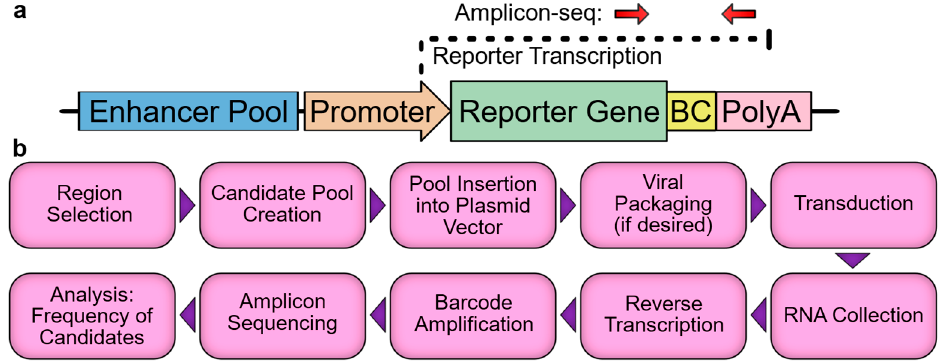
Figure 1. MPRA overview. ( a ) Schematic of a typical MPRA vector. Red arrows indicate PCR priming sites. BC, barcode. ( b ) Overview of MPRA work fl ow.